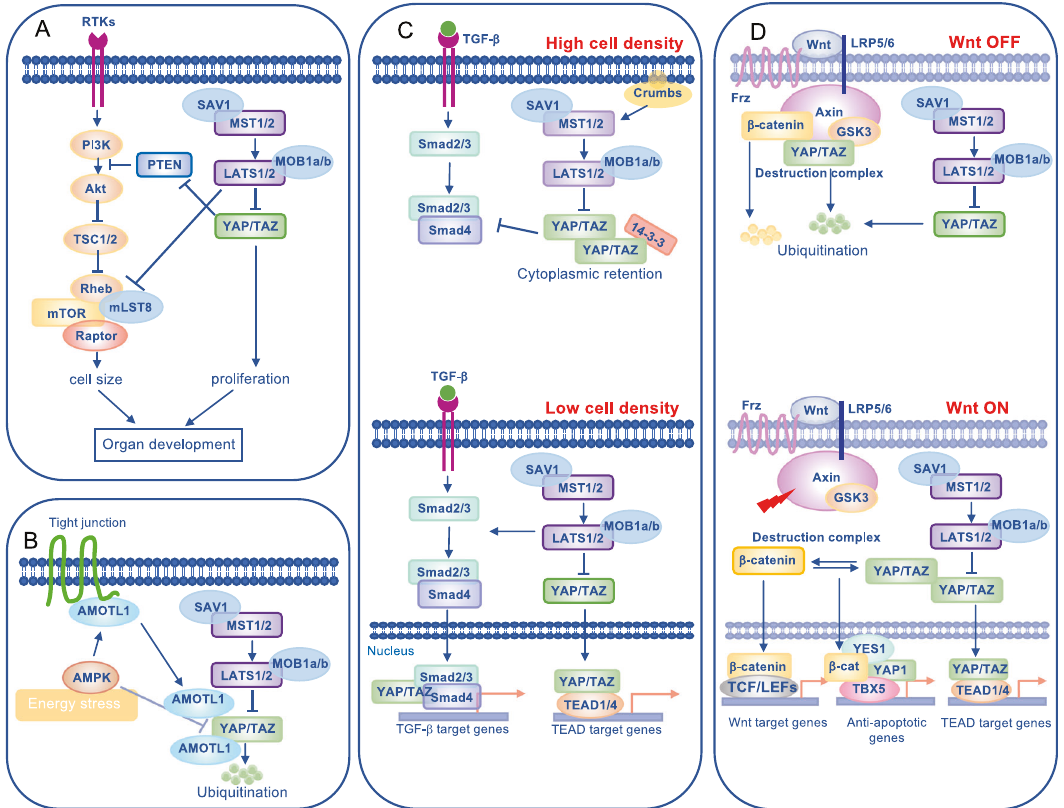
Fig. 2 Crosstalk of the Hippo pathway with other signaling networks. A The functional connection between mTOR (regulating cell size) and Hippo (regulating proliferation) pathways is essential for the proper organ development. At the basis of this crosstalk, YAP can downregulate PTEN (Phosphatase and tensin homolog), whereas LATS1/2 (Large tumor suppressor kinase 1/2) can phosphorylate Raptor, resulting in inhibition of mTOR signaling. B Under energy stress condition, the AMP-activated protein kinase (AMPK) phosphorylates and stabilizes AMOTL1 (Angiomotin Like 1), together with inducing both direct and LATS-mediated YAP phosphorylation, leading to YAP inhibition. C In conditions of high cell density, the Hippo pathway is activated and cytoplasmic YAP/TAZ retain TGF β (transforming growth factor β )-activated SMAD family members 2/3-4 (SMAD 2/3-4) in the cytoplasm. At low cell density, YAP/TAZ and SMAD 2/3-4 translocate to the nucleus to cooperatively induce transcription. D YAP and TAZ are members of β -catenin destruction complex, responsible for β -catenin inactivation. Upon activation of the Wnt pathway, YAP/TAZ and β -catenin enter the nucleus and synergistically induce Wnt and TEAD (TEA Domain transcription factor) target genes. Moreover, by complexing with TBX5 (T-box transcription factor 5), they induce anti-apoptotic